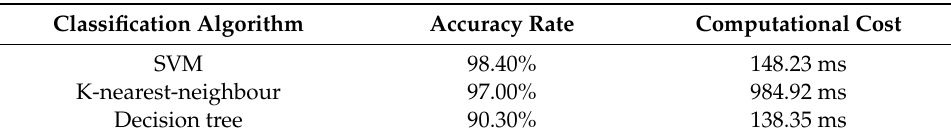
Table 4. Comparison of recognition results.